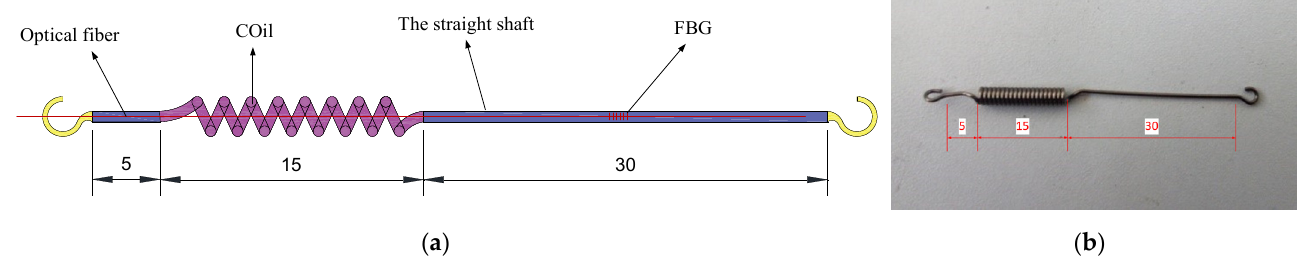
Figure 6. The structure and photo of spring desensitization sensor. ( a ) Structure diagram; ( b ) spring photo.